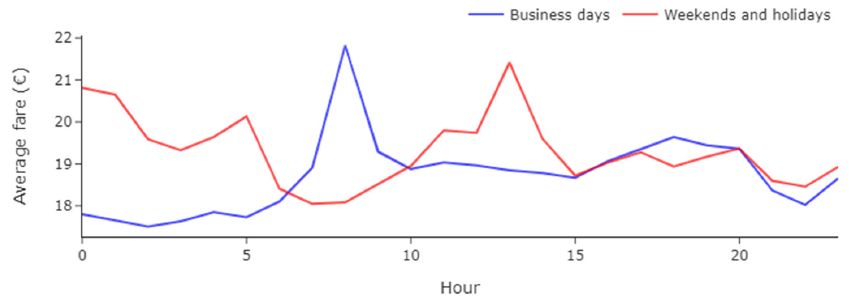
Figure 4. Average fare per hour and type of day.